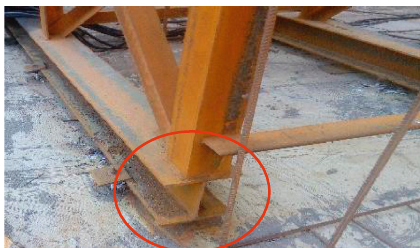
Figure 17: Deformation of scaffold connected to No. 2 joint.